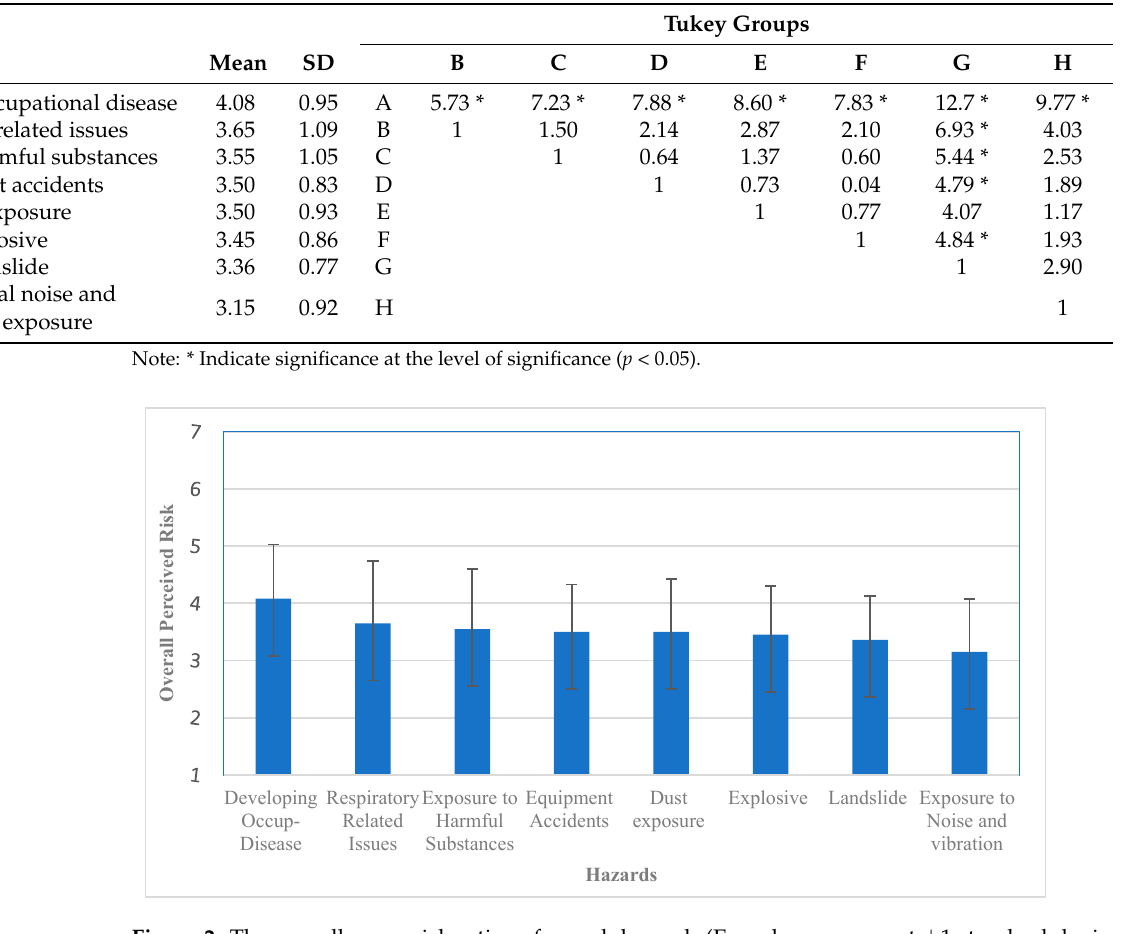
Figure 2. The overall mean risk ratings for each hazard. (Error bars represent ±1 standard deviation (SD)).